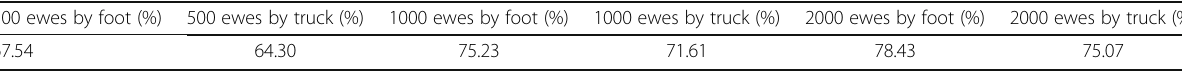
Table 7 Probability of transhumant being more profitable than semi-extensive